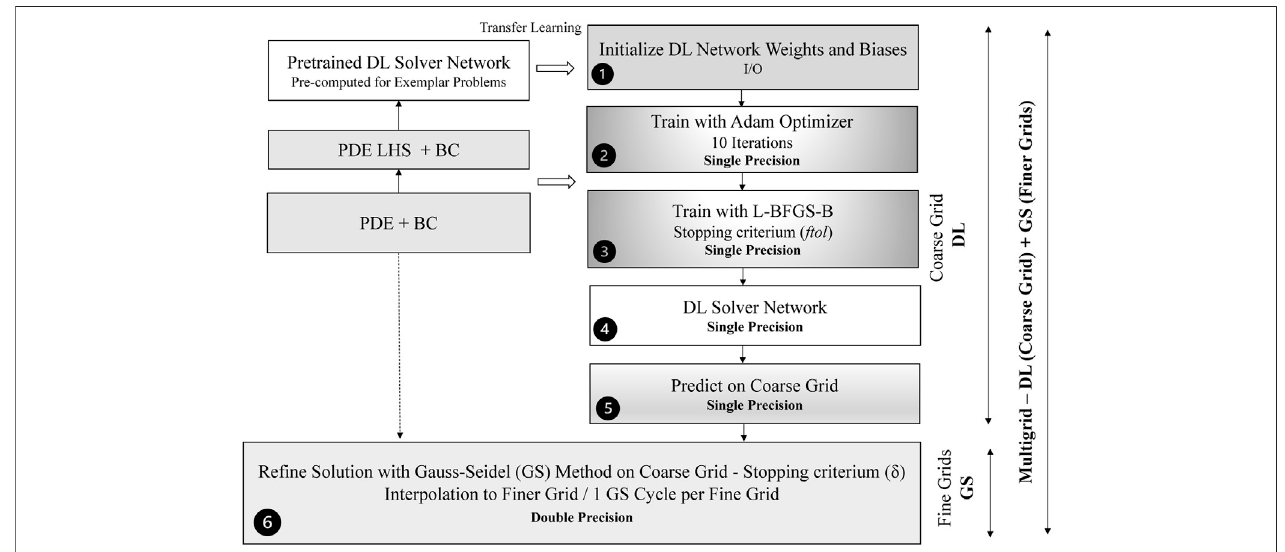
FIGURE 8 | Structure of the hybrid multigrid solver combining the DL and Gauss-Seidel solvers. Pre-trained networks are pre-computed and used to initialize the DL network. Two main parameters ftol , δ determine the accuracy and the performance of the hybrid solver.